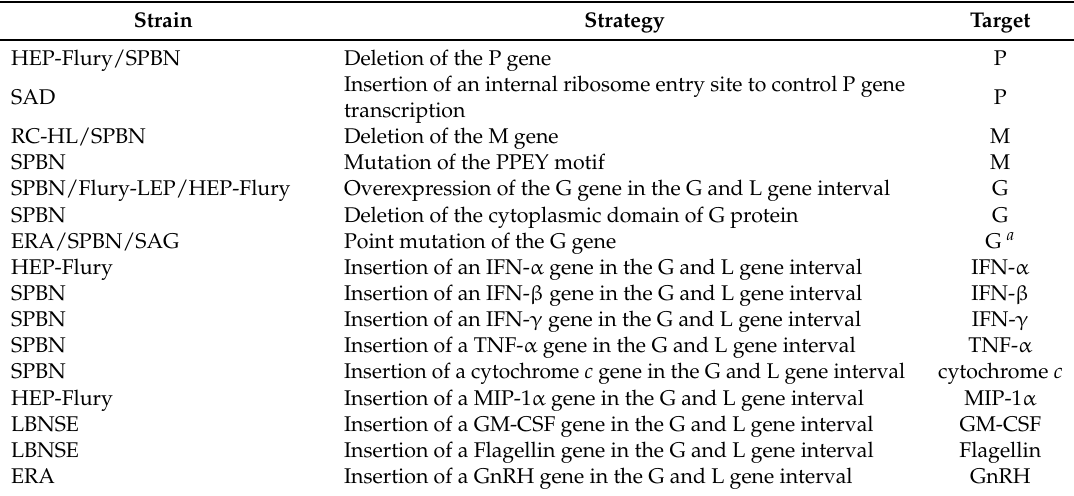
Table 2. Summary of experimental live RABV-based vaccines with potential to protect against lethal